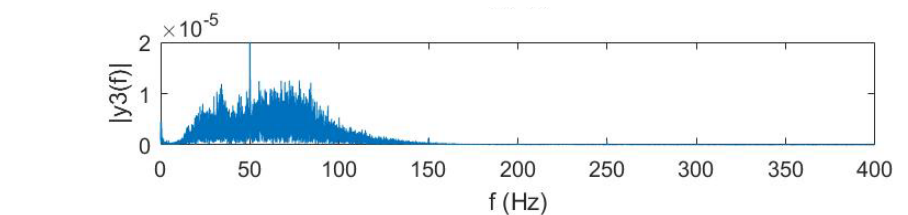
Figure 7 . Ground surface vibration measurement using the sensor array at the distance of 0.5 m from the leak.